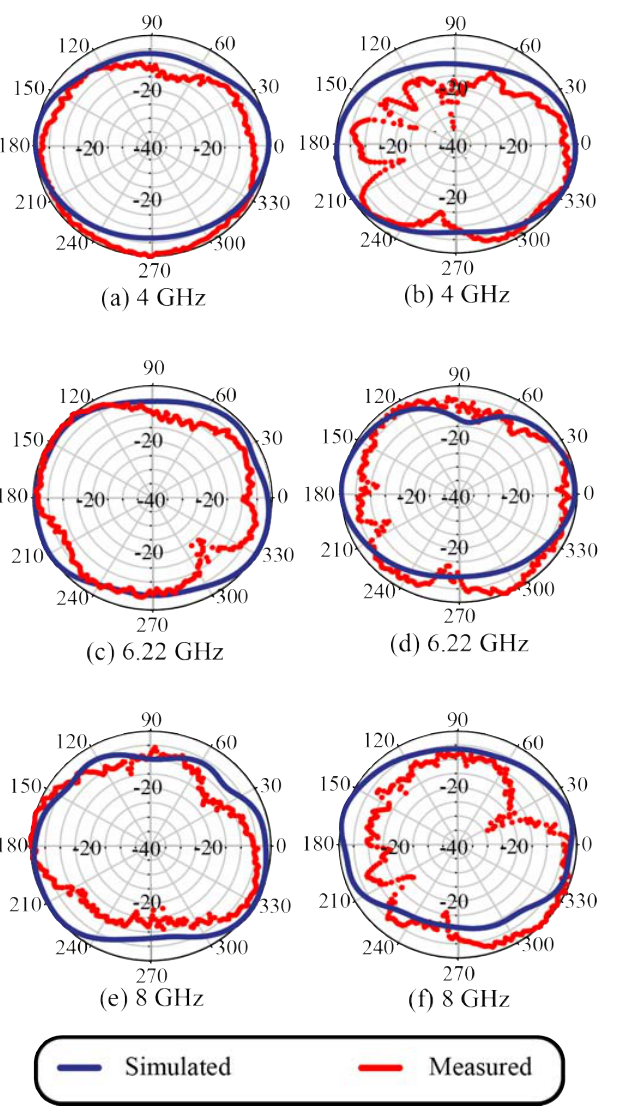
FIGURE. 15 Simulated and measured radiation patterns for 4 GHz, 6.22 GHz, 8 GHz, and 10 GHz (a), (c), (e) E-plane, and (b), (d), (f)